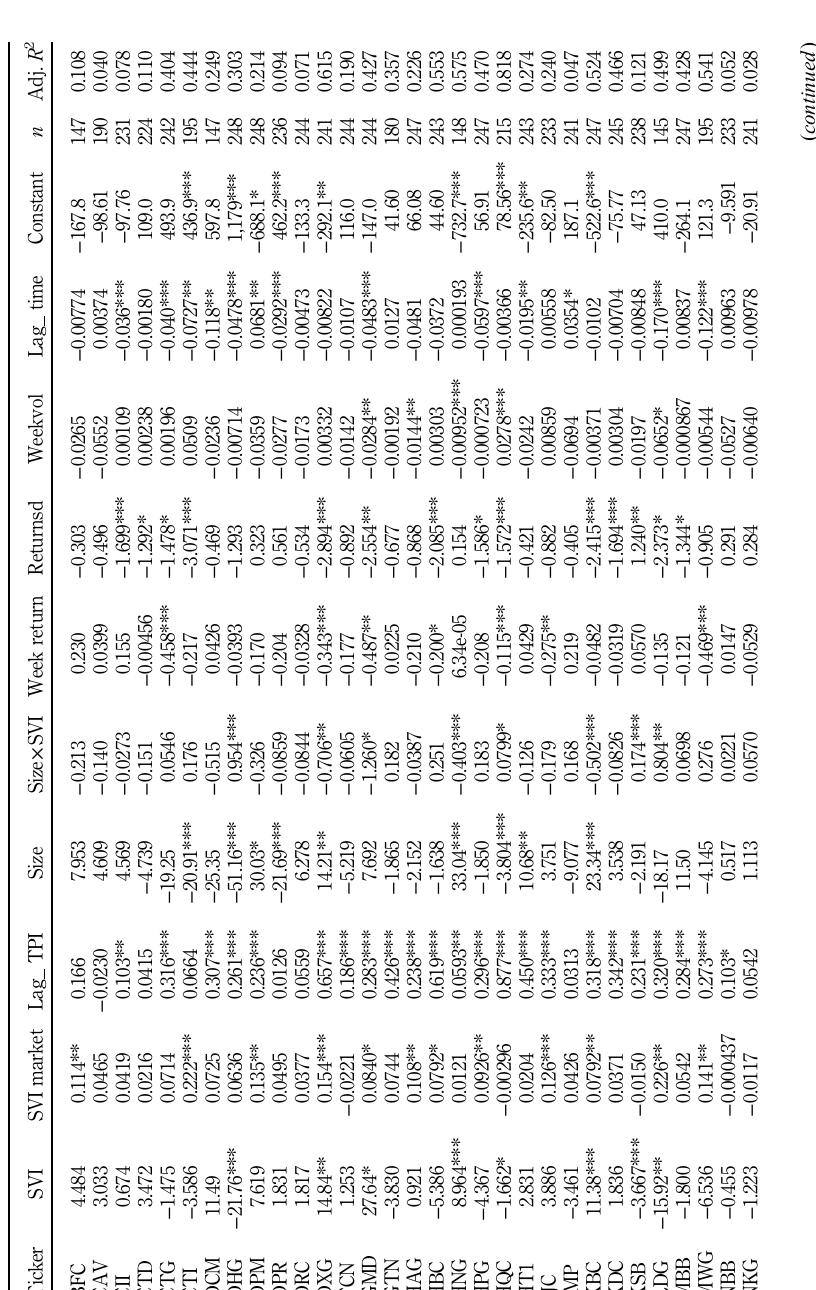
Table AI. Model I